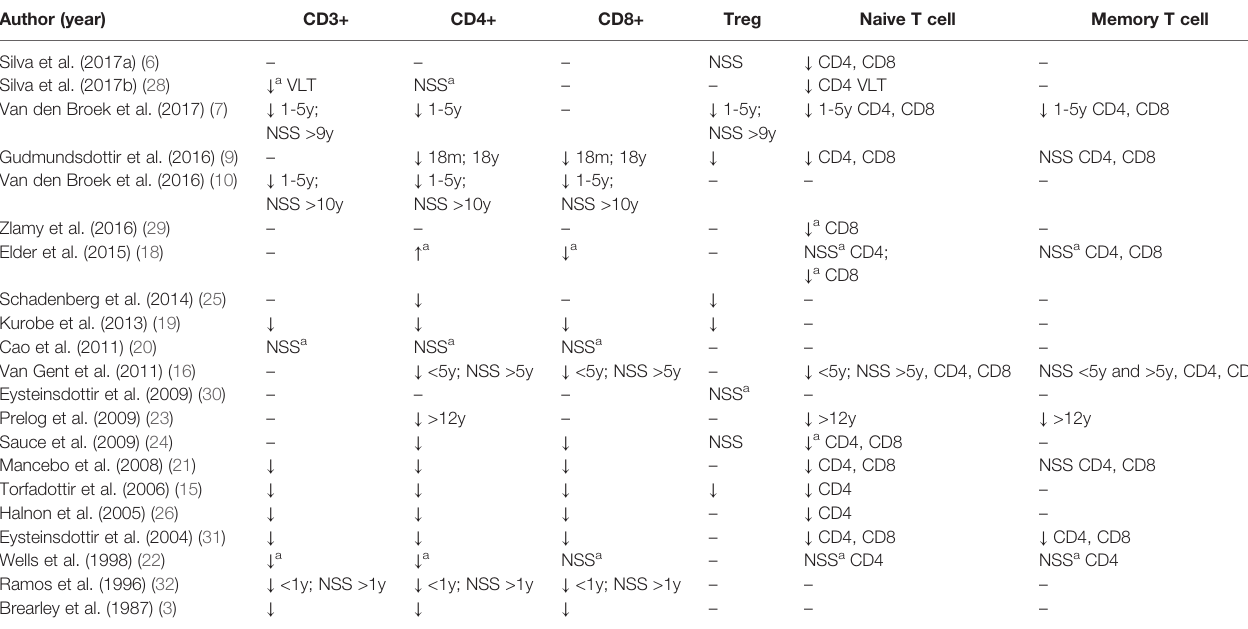
TABLE 4 | Main results regarding numbers of T cells and their subpopulations of included